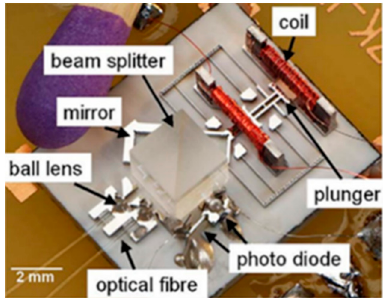
Figure 19. Top view of an electromagnetically actuated miniature FTS using the LIGA process. (Reprinted with permission from Reference [43] Elsevier).